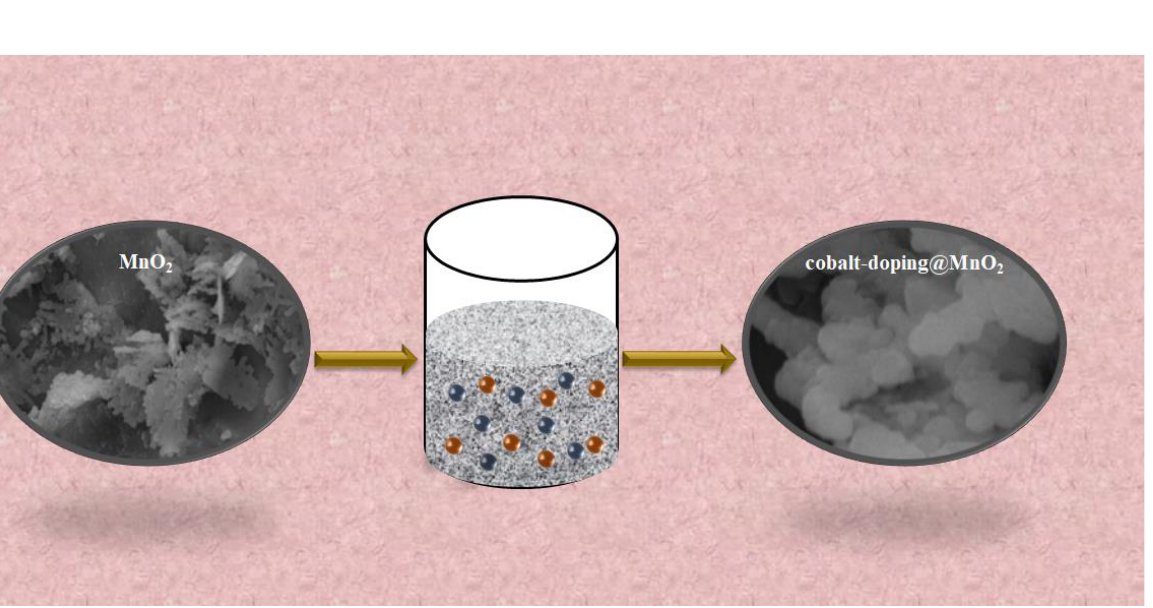
Figure 1. Schematic diagram of the cobalt-doped@MnO 2 nanosheets composite. Figure 2a indicates a typical SEM image of the MnO 2 nanoparticle material. The MnO 2 nanoparticle appears with distinct porous architecture. The internally networked porous